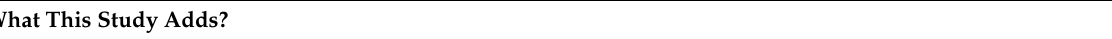
Table 1. The Contribution of this